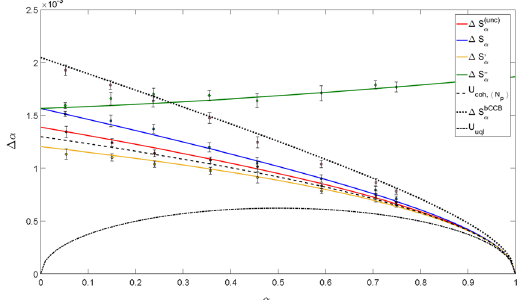
Figure 4. Uncertainty on α in function of the mean value of α . Four different estimators are considered. Solid lines are the theoretical curves, dashed and dotted lines are the limits corresponding to the best quantum and classical cases when the same mean energy of the probe and the same detection efficiency are considered. The markers are the experimental data. In this configuration the measured efficiencies are η P = 0.76 and 4 . In this condition Δ > Δ unc ( ) while Δ S ′ = 0.43 < 0.5, while 〈 〉 ⋅ ~ N 50 10 η α remains below the classical α α S S R P benchmark.